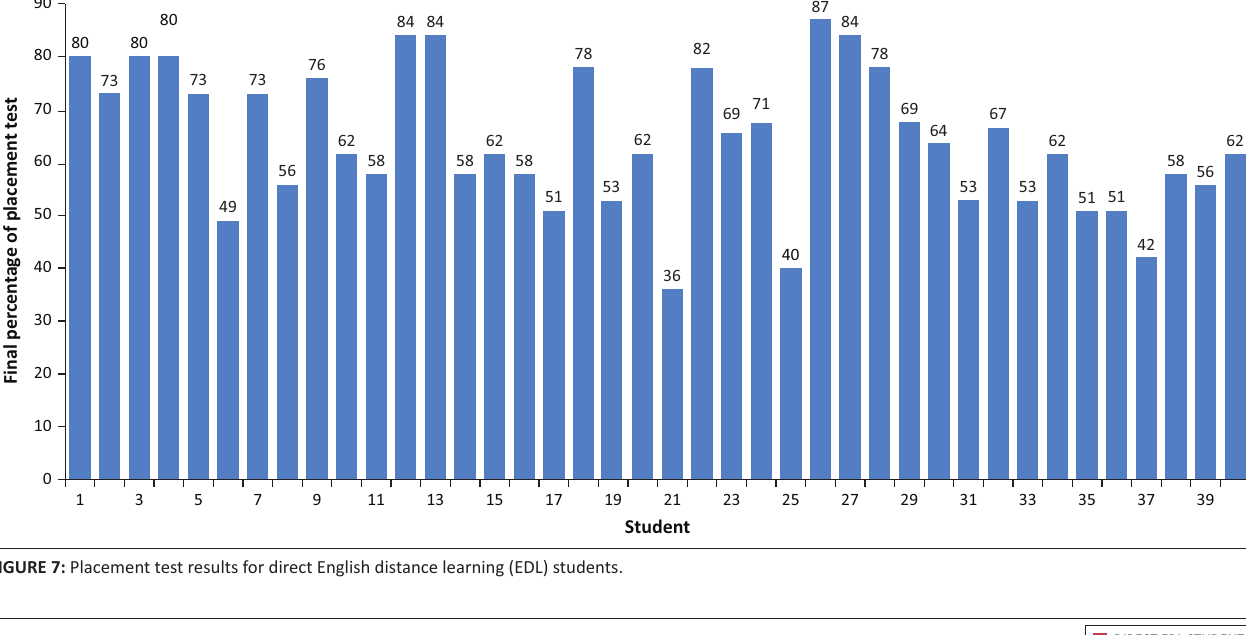
Comparison of overall average % between the two groups